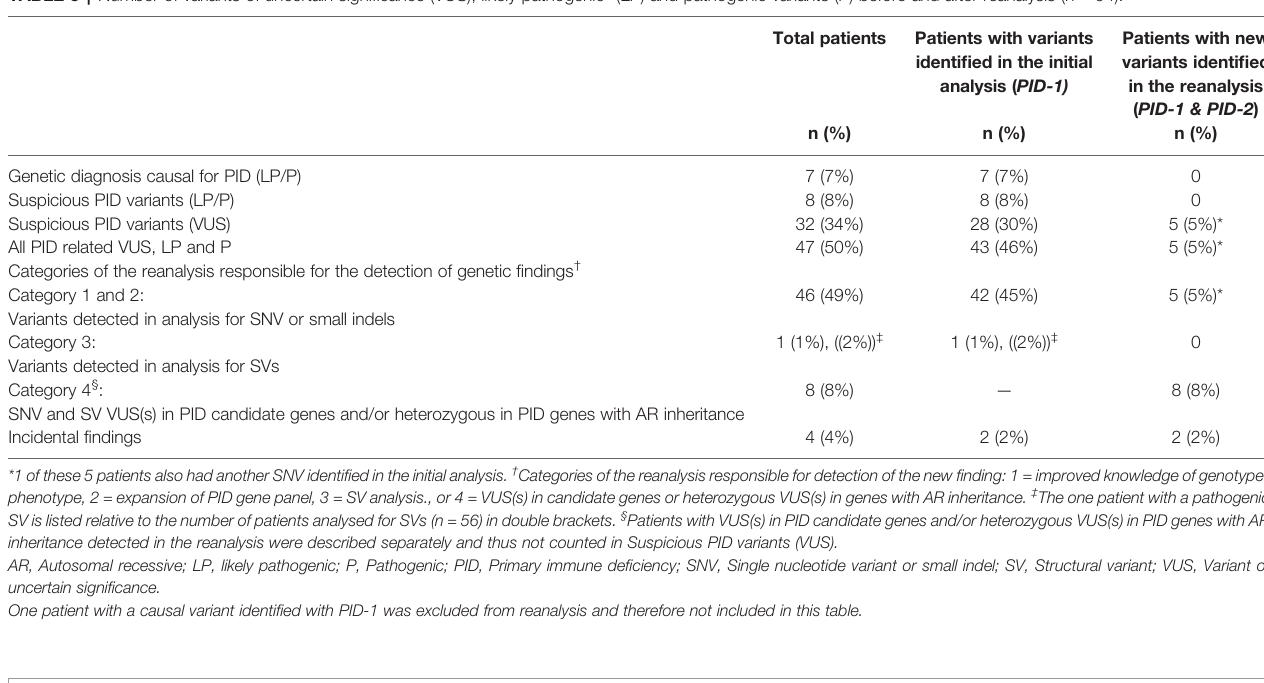
TABLE 3 | Number of variants of uncertain signi fi cance (VUS), likely pathogenic- (LP) and pathogenic variants (P) before and after reanalysis (n = 94).